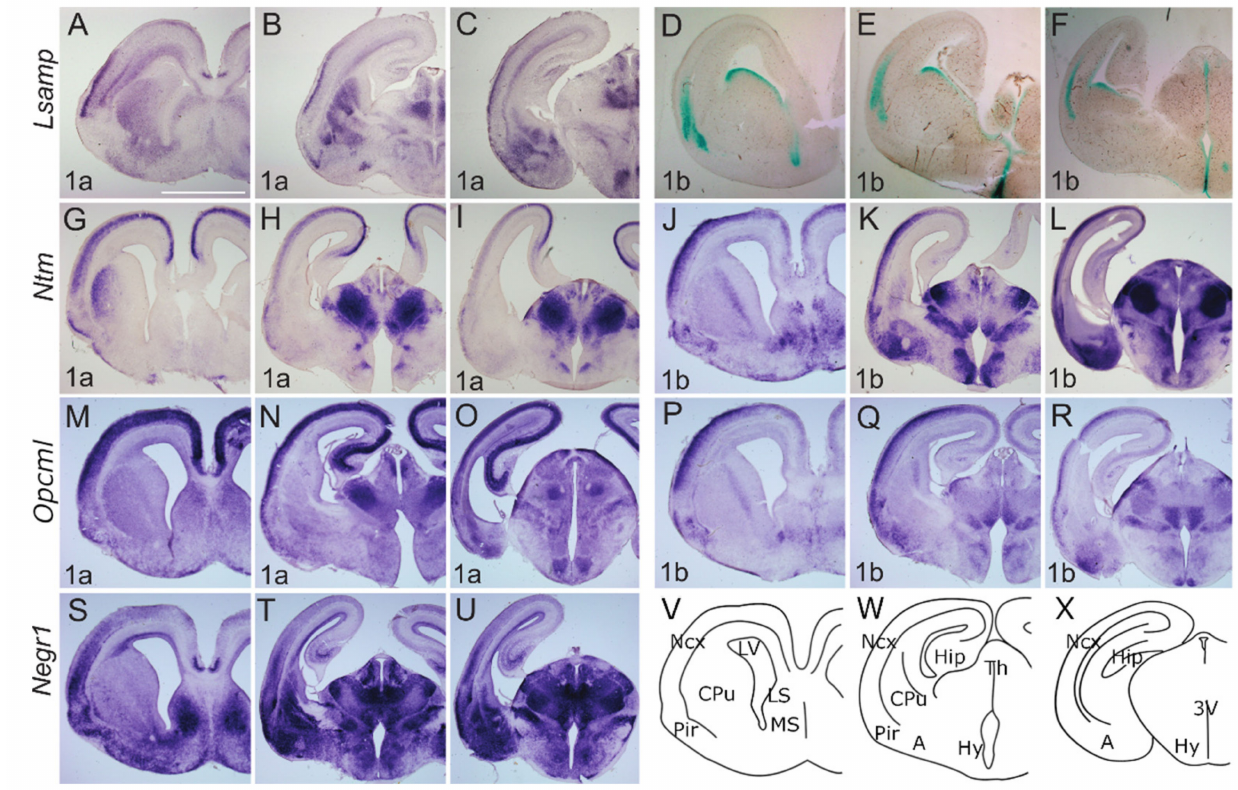
Figure 4. Expression from IgLON alternative promoters at E17 mouse CNS. ( A – C ; G – U ) In situ mRNA hybridization; ( D–F ) X-gal staining. ( A , D , G , J , M , P , S ) coronal sections through the level of olfactory tuberculum and septum. ( B , E , H , K , N , Q , T ) sections pass through the middle part of Amy and diencephalon; ( C , F , I , L , O , R , U ) through the caudal part of Amy and diencephalon. Lsamp 1a is strongly expressed laterally in upper layers of neo- and allocortex as well as in subplate region; the expression is seen in developing CPu, Amy; and thalamic nuclei. ( D – F ) Overall the expressions of Lsamp 1a and 1b are largely complementary: Lsamp 1b expression is visible at the ventral portion of lateral ventricles and moving caudally, lines the third ventricle. ( G – I ) Ntm 1a and ( J – L ) Ntm 1b are strongly detected at upper layers of the developing cortex. ( G ) in CPu, Ntm 1a is seen laterally beneath the developing white matter, whereas ( J ) Ntm 1b is seen in the more internal part of CPu. Strongest expression of ( H , I ) Ntm 1a and ( K , L ) Ntm 1b is seen in thalamic nuclei. Unlike Ntm 1a ( K , L ) the